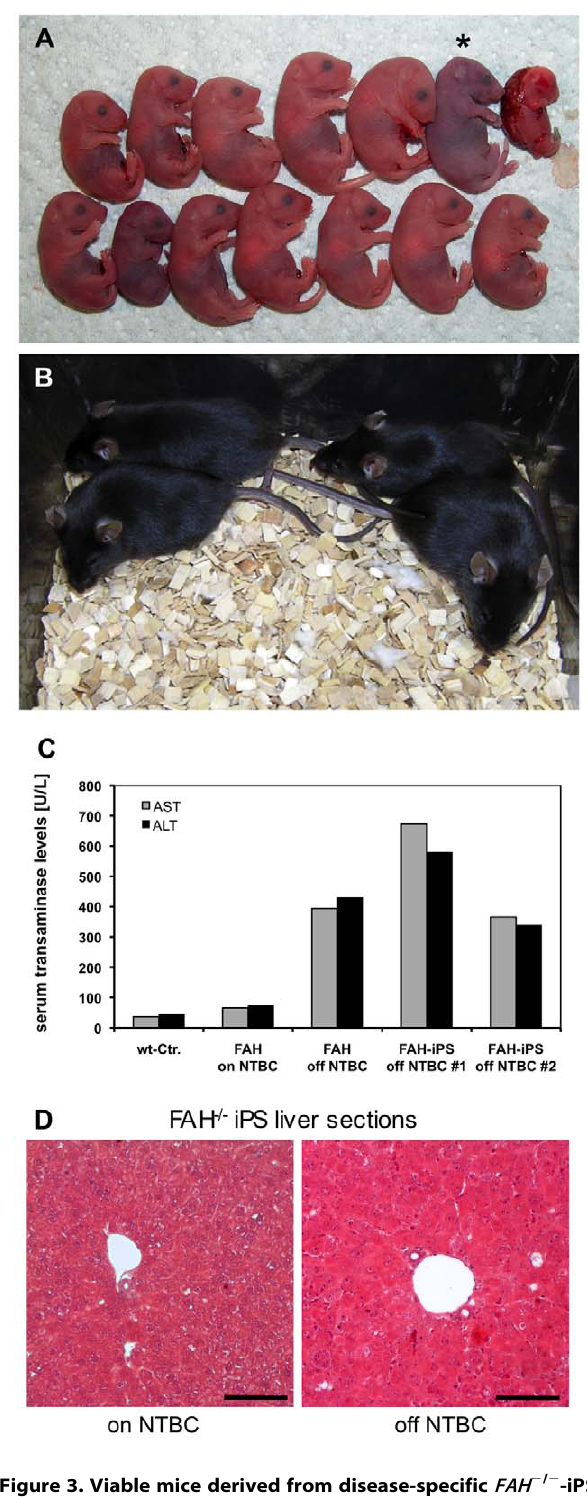
Figure 3. Viable mice derived from disease-specific FAH 2 / 2 -iPS cells via tetraploid embryo complementation. (A) Neonatal FAH 2 / 2 -iPS cell–derived pups delivered by caesarean section on E19.0. In this particular experiment, 13 pups showed normal full-term development, of which only one failed to initiate breathing (*). (B) FAH 2 / 2 -iPS mice demonstrated normal postnatal development upon rescue of the underlying metabolic defect by NTBC supplementation. (C) Transaminase activity of AST (grey bars) and ALT (black bars) in the serum of untreated FAH 2 / 2 mice (off NTBC) indicated severe